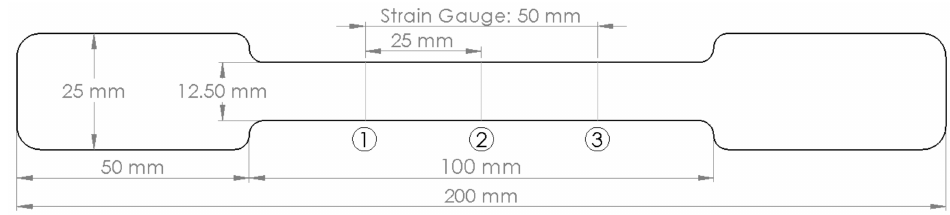
Figure 6. Tensile dog bone sample specification; the only sample type utilised in this study.